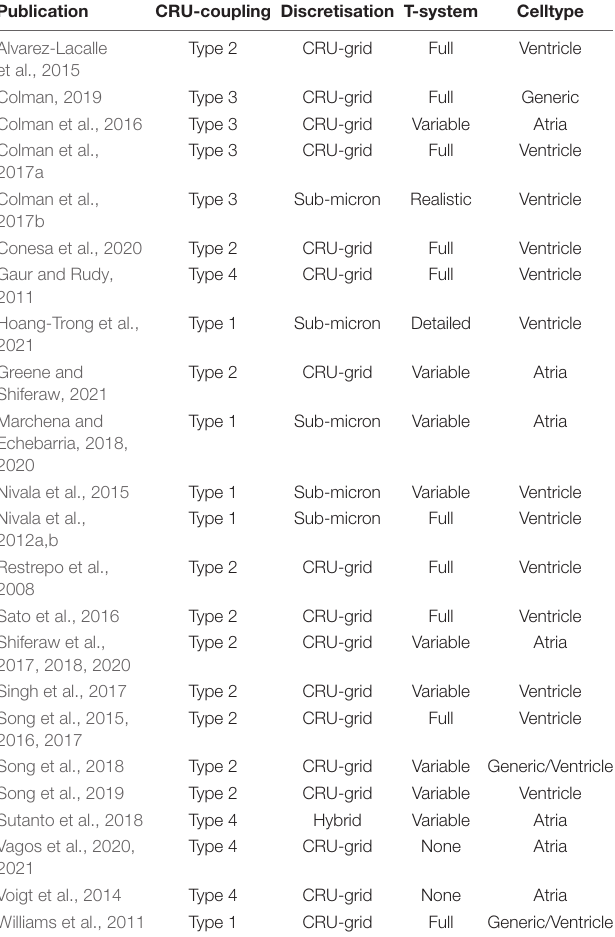
TABLE 1 | Summary of properties of whole-cell models of spatio-temporal Ca 2 +